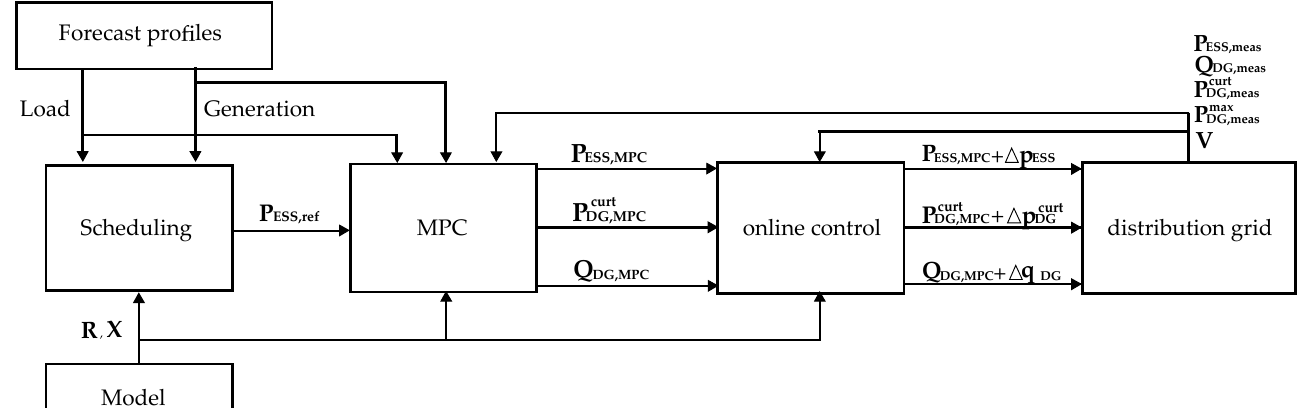
Figure 1. Proposed multi-timescale